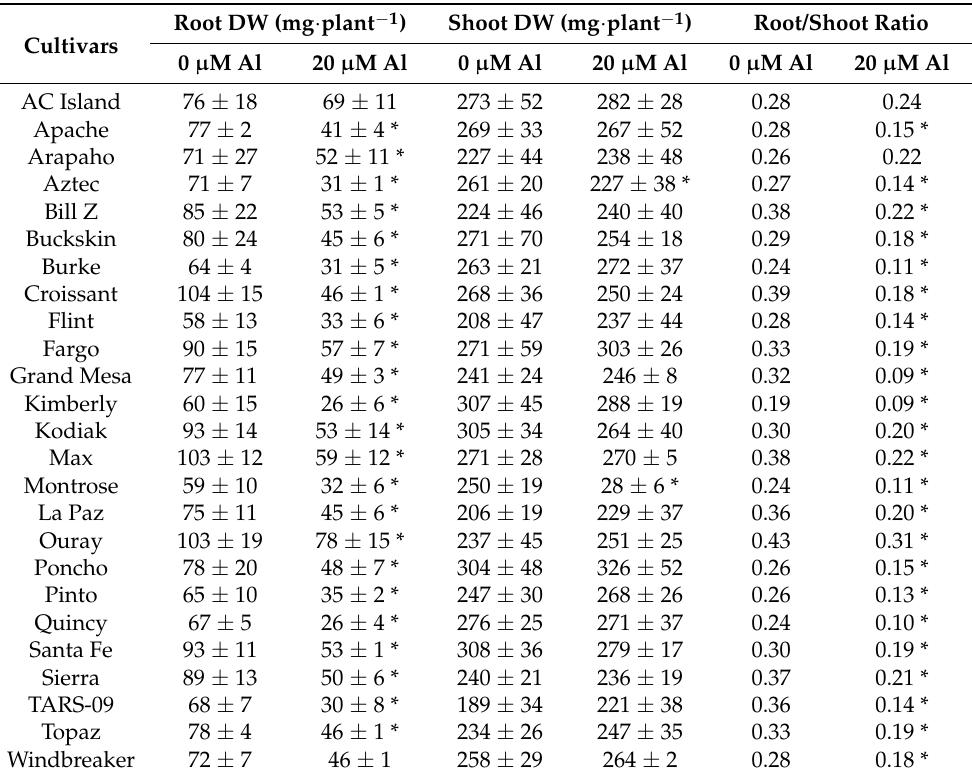
Table 1. The effect of AlCl 3 on the dry weight of roots and shoots (DW) (mg · plant − 1 ), as well as the root-to-shoot ratio, of 25 common bean cultivars grown for 3 days in hydroponics.